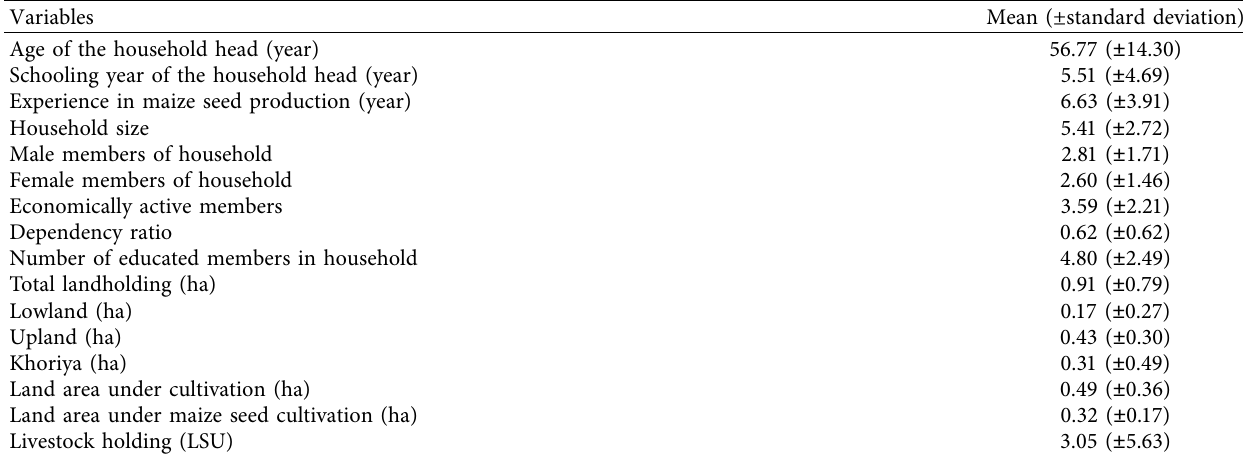
Table 1: Socioeconomic and demographic characteristics of the sampled households (continuous variables).